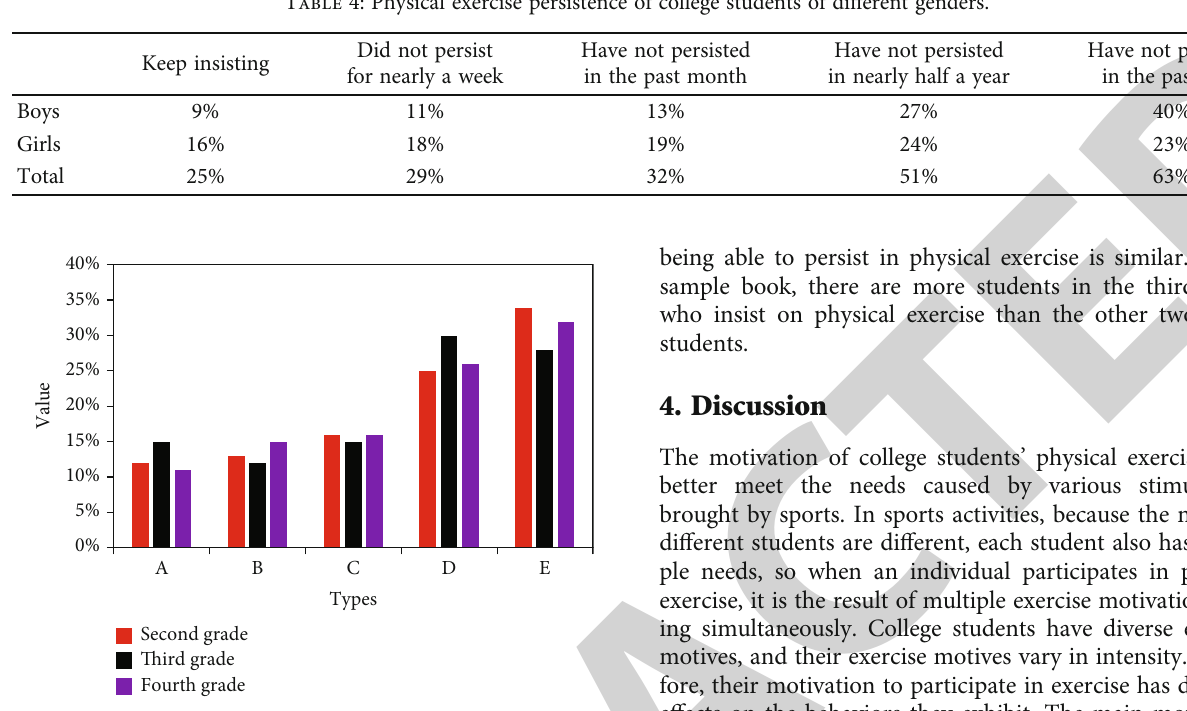
Table 4: Physical exercise persistence of college students of di ff erent genders.